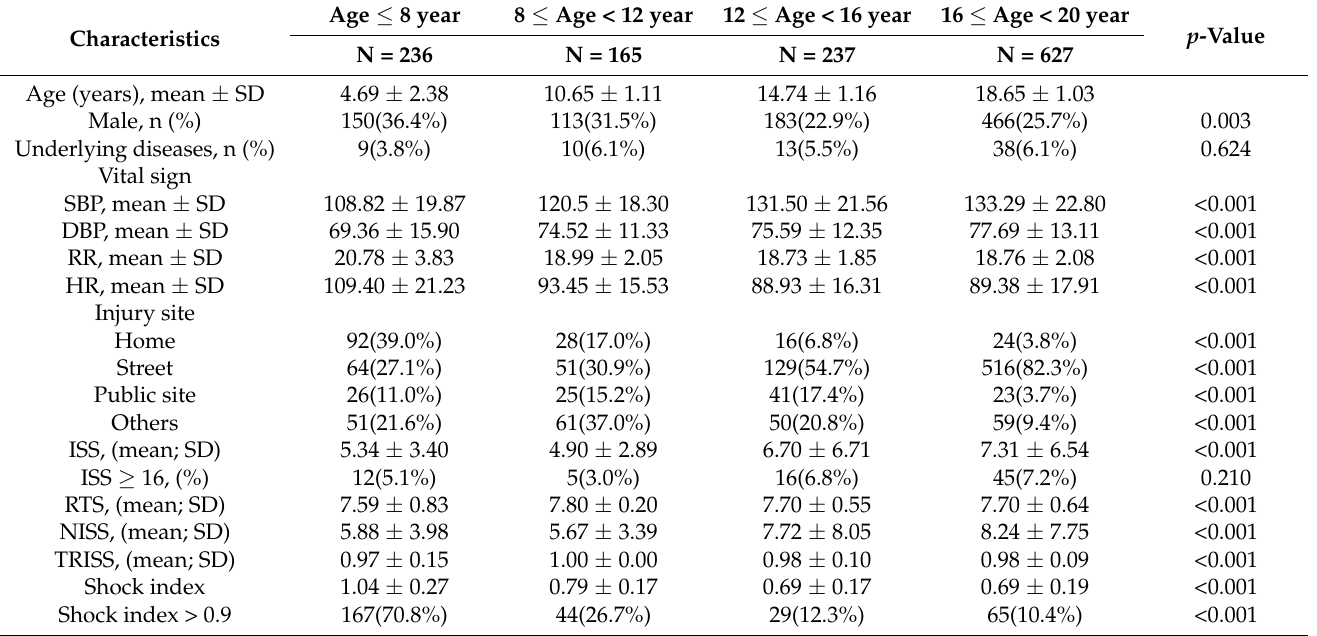
Figure 5. The area under the receiver operating characteristic curve (AUROC) of shock index > 0.9 and elevated pediatric age-adjusted SI (SIPA) predicting mortality, intensive care unit (ICU) admission, and need for surgery in population with age ≤ 16. Table 5. Subgroup analysis of elevated shock index and age-adjusted pediatric shock index in different age